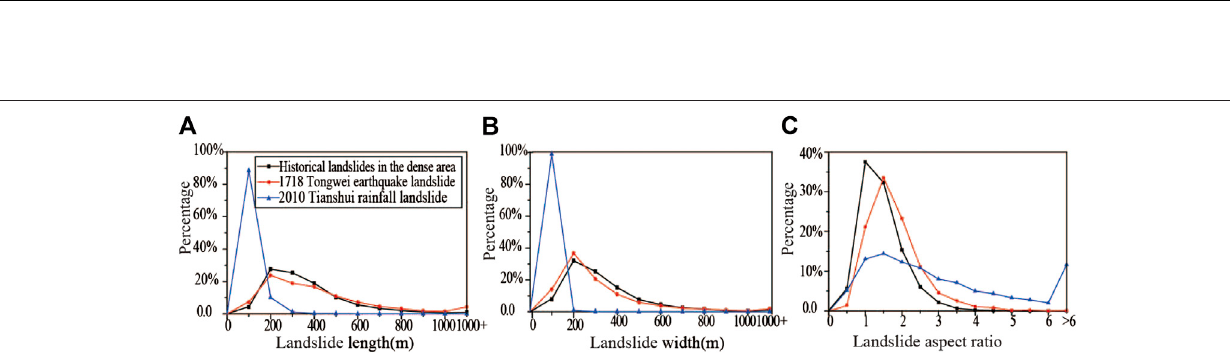
Frontiers in Earth Science |